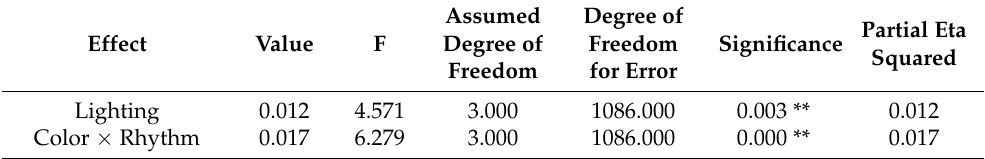
Table 12. MANOVA analysis results of subjective cognition in waiting-to-restart scenario.